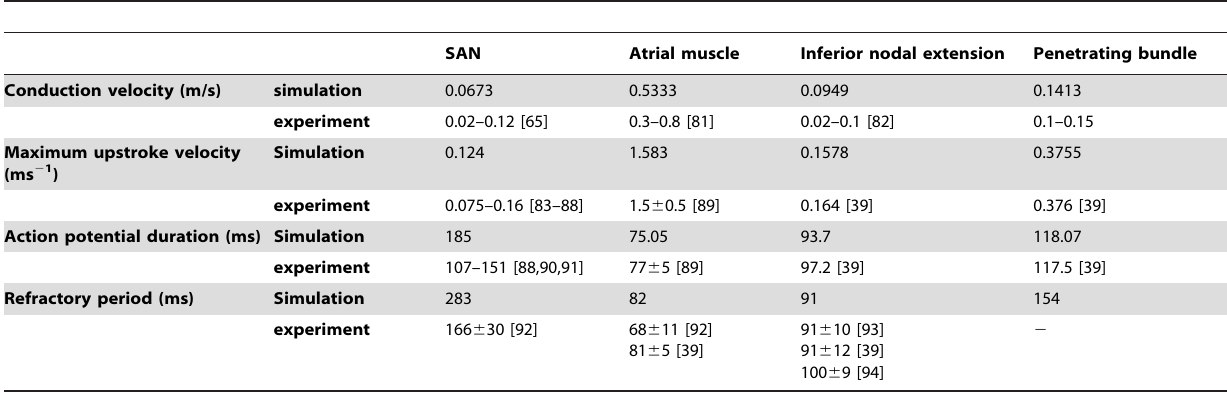
SAN Atrial muscle Inferior nodal extension Penetrating